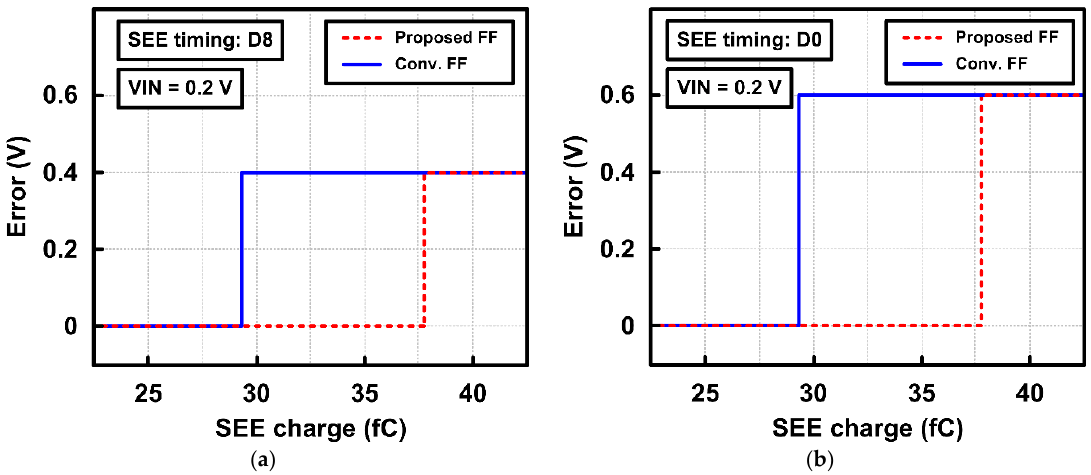
Figure 15. Output error voltages in the SAR ADC depending on SEE charge ( a ) when SEE occurs at D8 timing and ( b ) when SEE occurs at D0 timing.